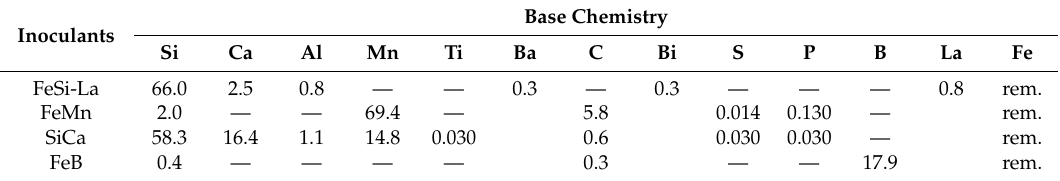
Table 2. Chemical composition of the inoculants, expressed in weight percent (wt.%).